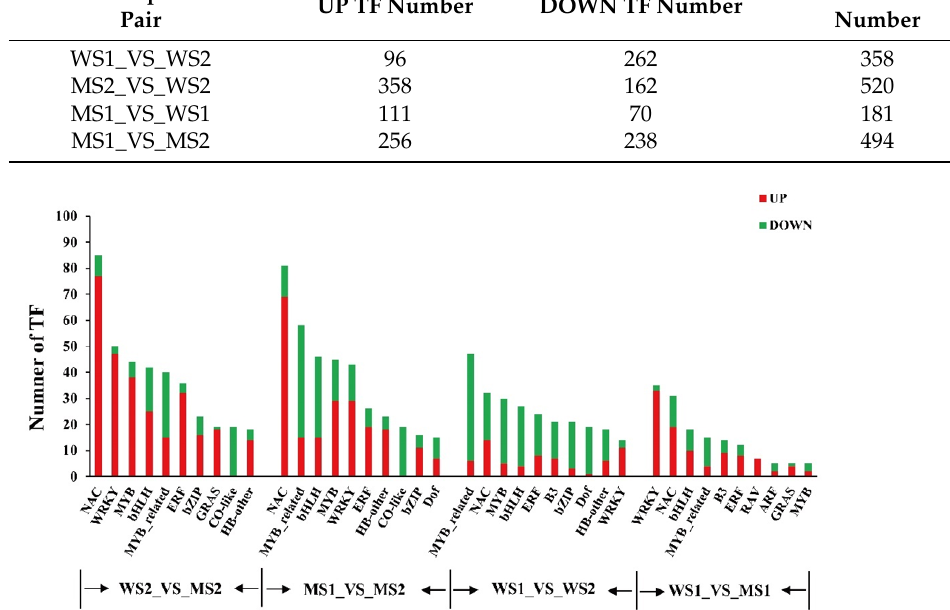
Figure 9. Statistics of the number of different transcription factors involved in the activity of sequence specific DNA binding transcription factors under the comparison of four groups.